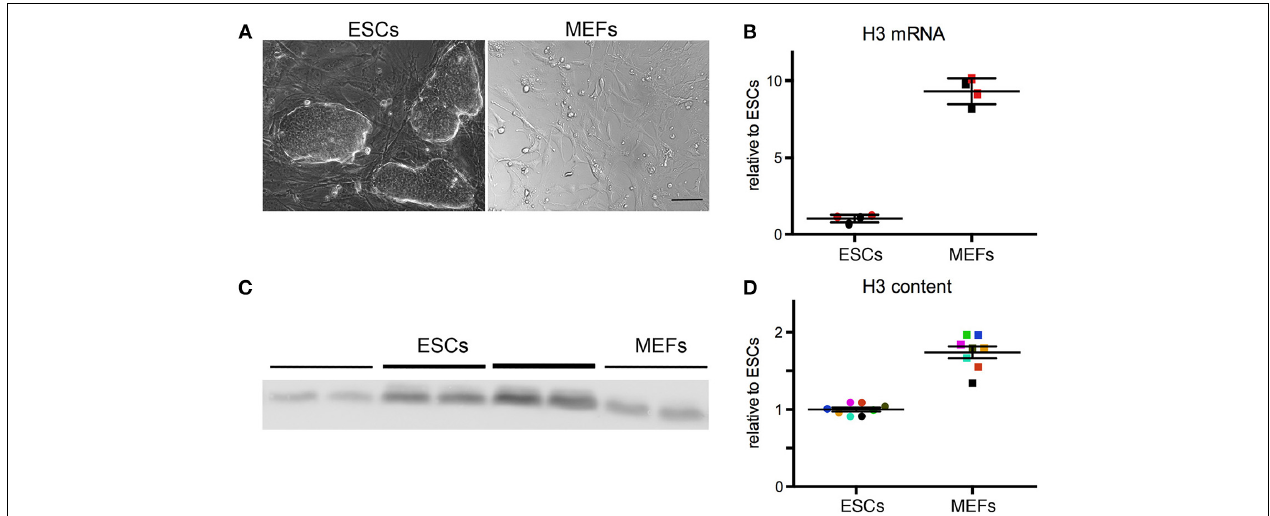
FIGURE 2 | (A) R1 and CCE ESCs were cultured under ES-like conditions, and C57/BL6 and BALB/C MEFs isolated from E14.5 embryos were cultured under standard conditions. Scale bar 50 μ m. (B) ESCs express less H3 mRNA than MEFs. Each dot represents a different biological replicate. Color codes identify samples analyzed in the same batch the same day; different colors represent samples analyzed in different days. The mean and standard deviation are indicated by horizontal lines. The groups are statistically different (Mann-Whitney test, p = 0 . 029). (C)